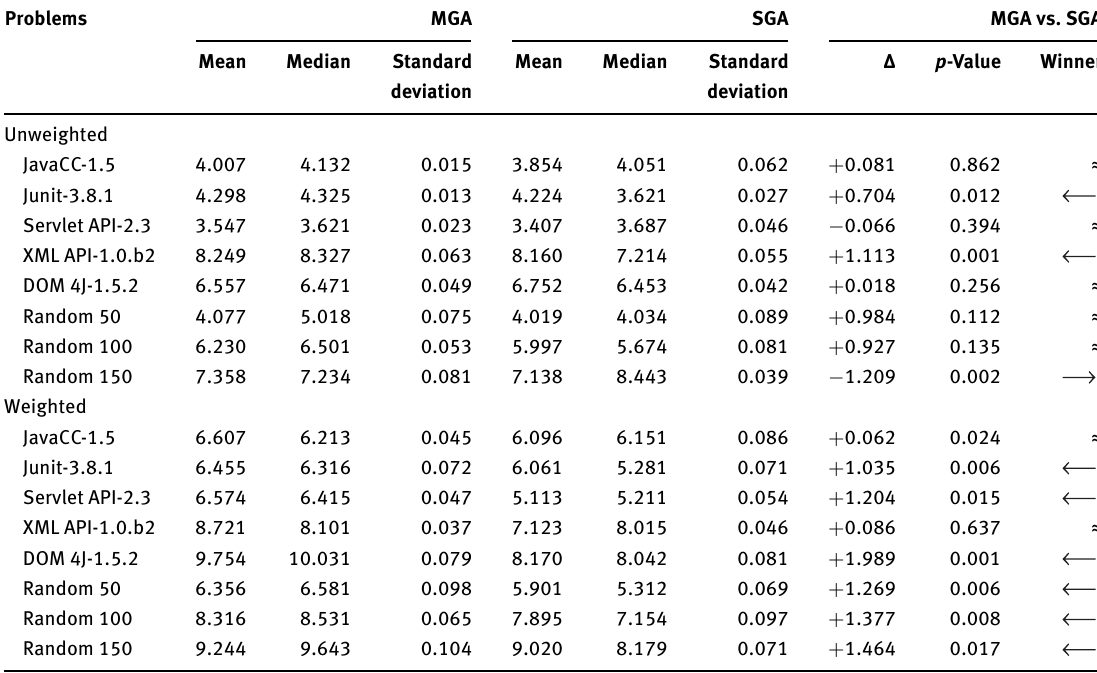
Table 2: Mean, Median and Standard Deviation of MQ Measure Obtained by Global Optimization. Problems MGA SGA Mean Median